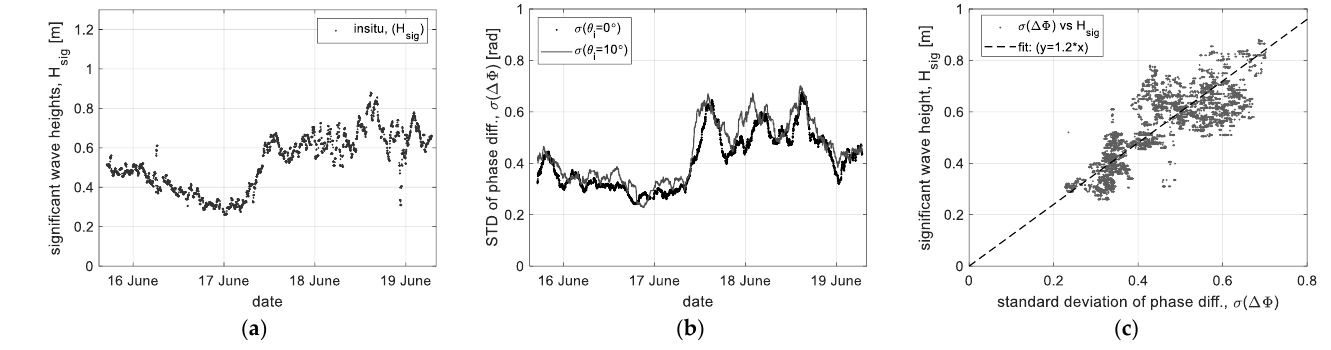
Figure 10. Correlation analysis of the ‘HPF’ data ( ΔΦ) versus the significant wave height ( H sig ): ( a ) the in situ data of significant wave height, ( b ) the data ( σ ( ΔΦ )) reprocessed by statistical analysis, and ( c ) correlation between the relative velocity and significant wave